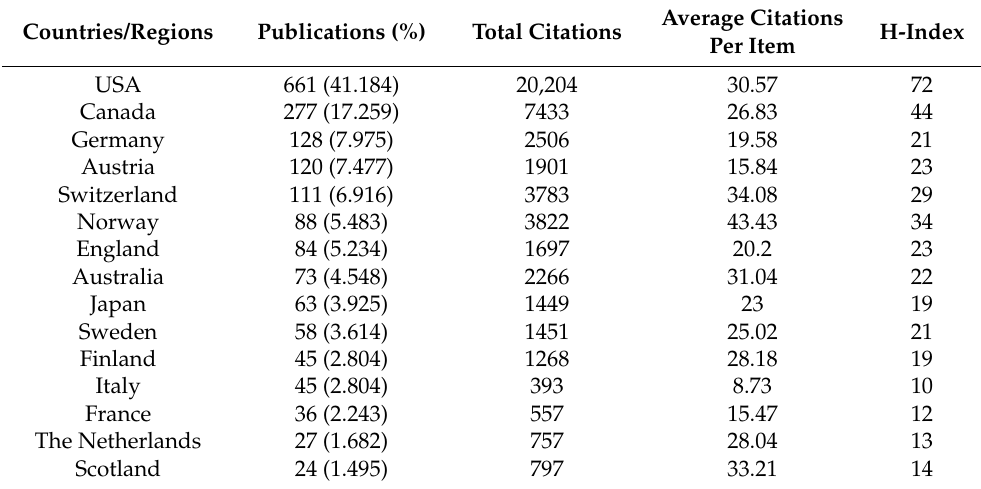
Table 1. The top 15 most published and cited active countries/regions in the top 3 research directions related to snow and ice sports